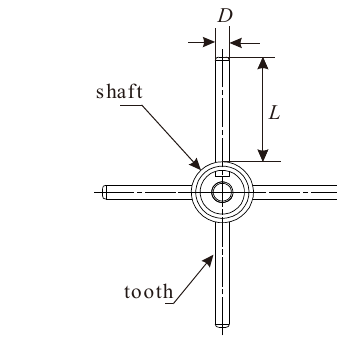
Figure 2. Model of a winding roller.